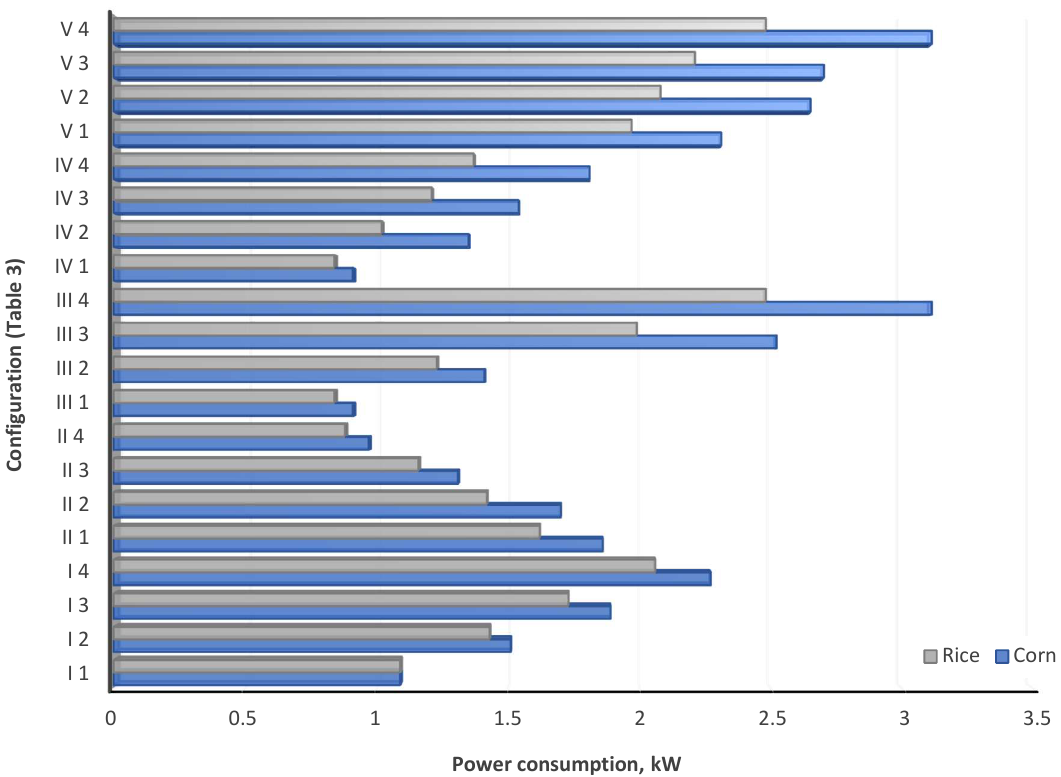
Figure 4. Test results of the power consumption for rice and corn grinding.